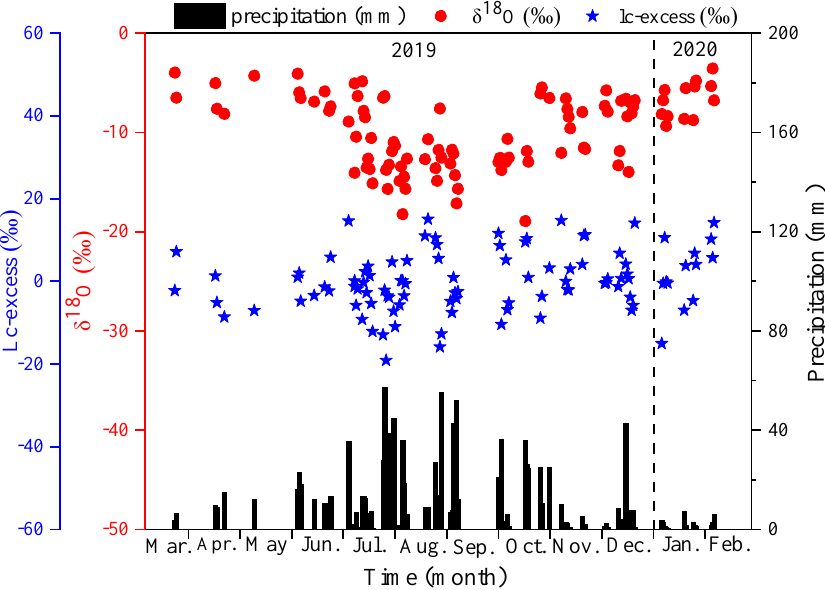
Figure 3. Daily variations of δ 18 O, lc-excess (the difference between the value of δ 2 H and the location of the meteoric water line), and precipitation.